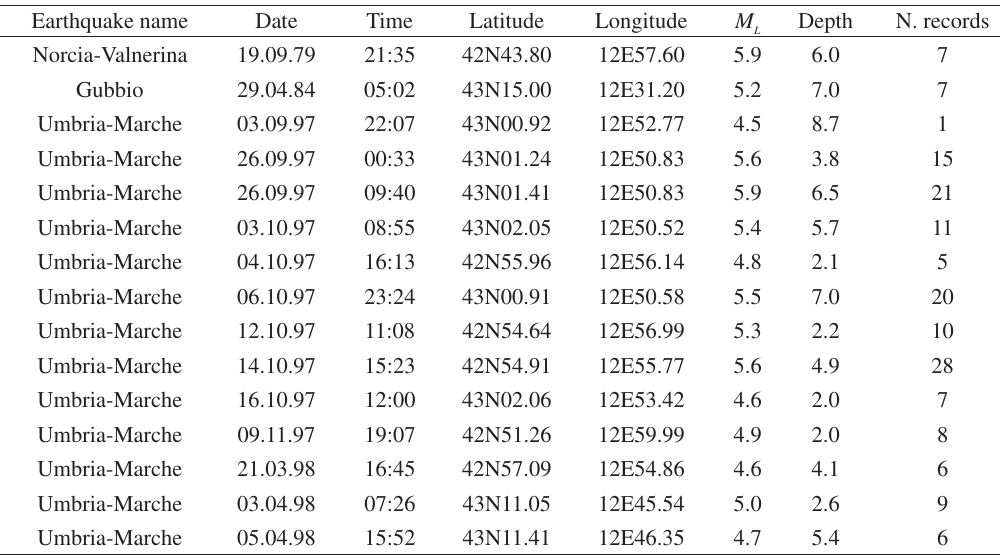
Table I. List of the Umbria-Marche, Central Italy, earthquakes used in this study. Earthquake